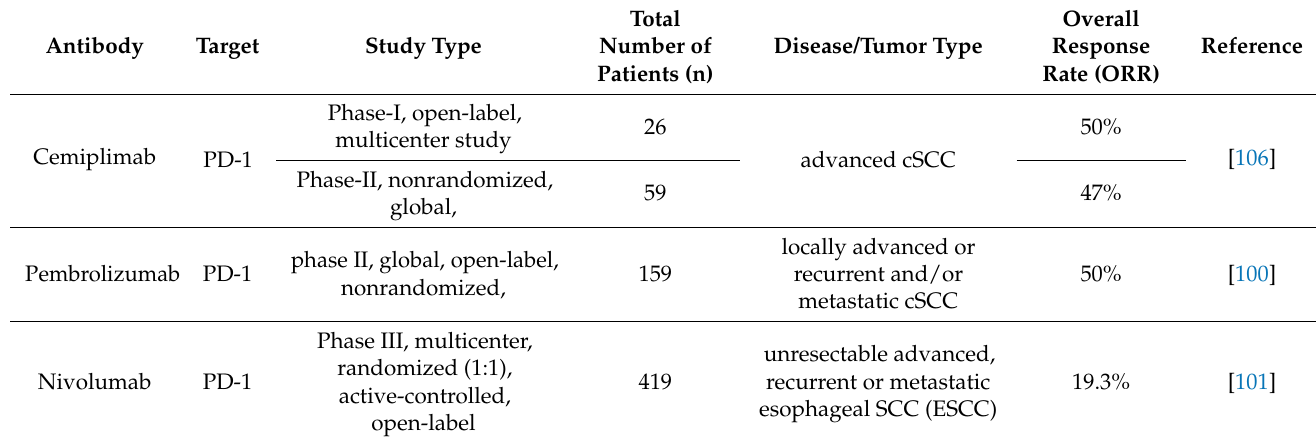
Table 2. FDA approved PD-1 antibody for the treatment of SCC.